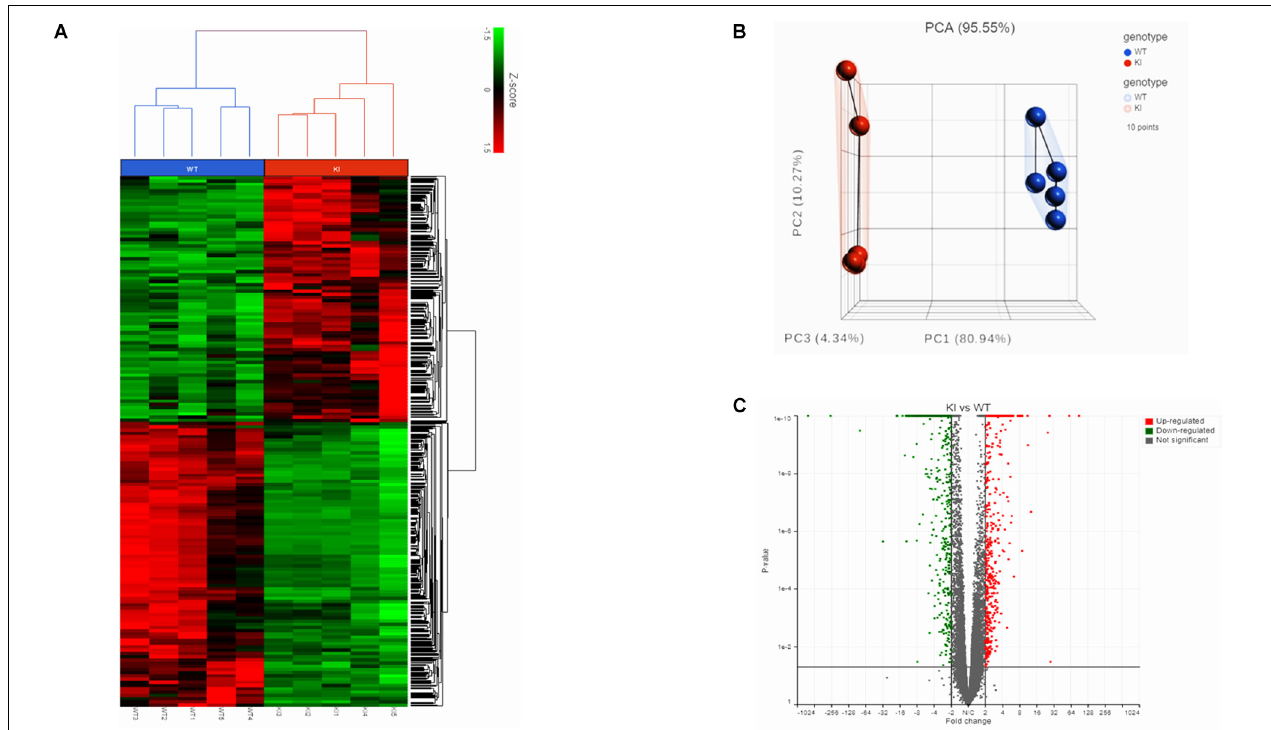
FIGURE 1 | Transcriptome analysis of germ cells from KI and WT mice. (A) Hierarchical clustered heatmap showing the expression patterns of significantly (fold change ≤ –1.5 or ≥ 1.5; p < 0.05) DEGs. The red boxes indicate the up-regulated genes, and the green boxes indicates down-regulated genes. Colored bar represents the expression levels. (B) PCA plot showing clustered samples based on the KI and WT genotype. Each point represents replicate sample for each genotype. (C) Volcano plot (fold change vs P -value) showing 2624 DEGs from KI and WT group ( n = 5 per group). Red dots represent up-regulated genes and green dots down-regulated genes in KI vs